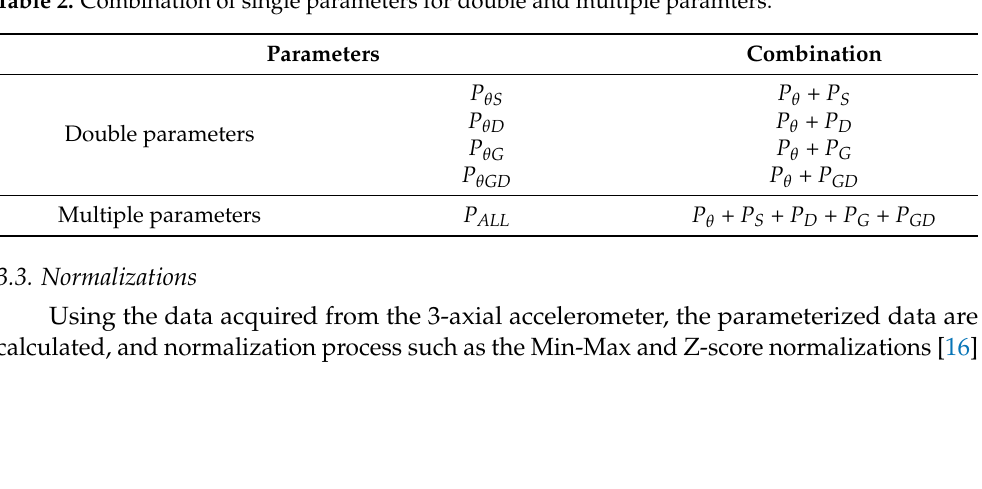
Table 2. Combination of single parameters for double and multiple